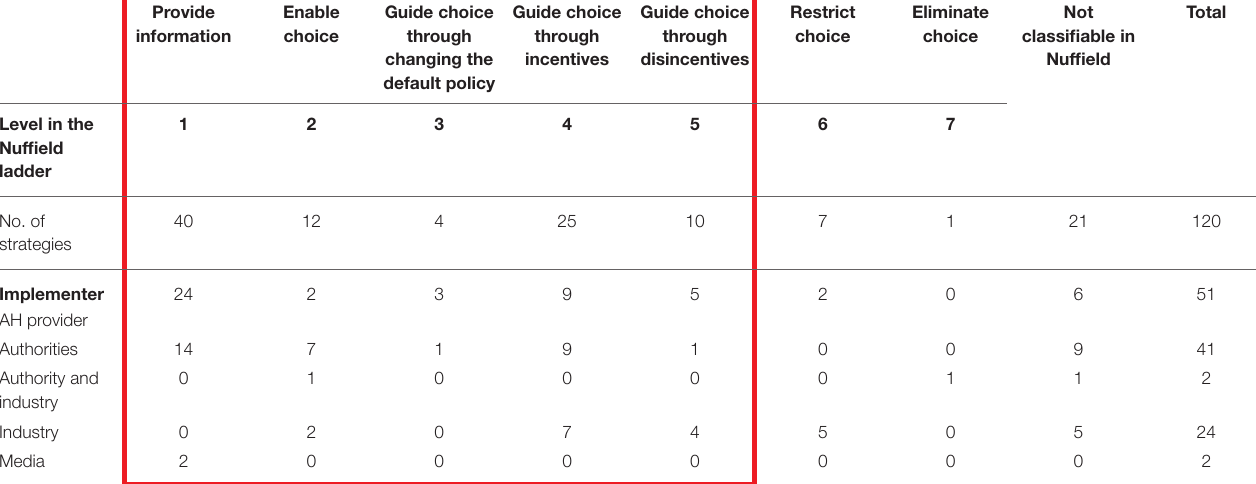
TABLE 3 | Overview of strategies based on the strength of intervention (the Nuffield ladder) and relation to the